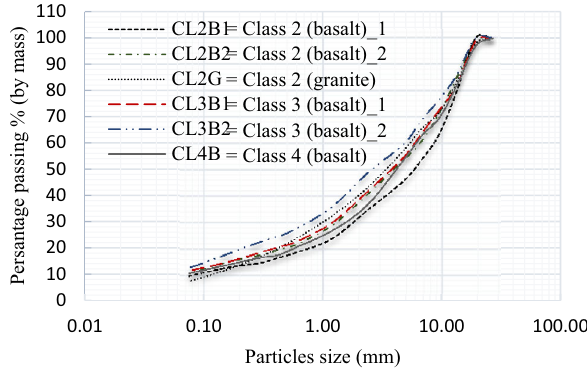
Fig. 3 Particle size distribution of the tested materials Table 4 PD testing matrix Material Gradation Moisture content (%)